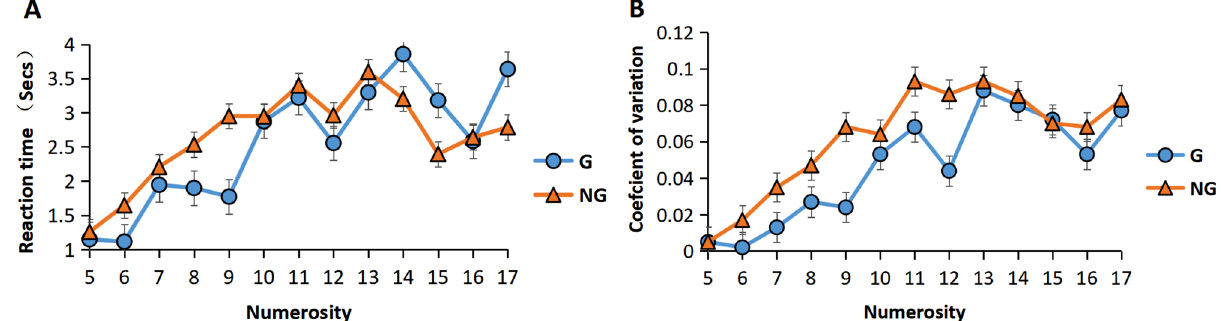
Figure 4. Specific numerosities. RTs ( A ) and CV ( B ) for different numerosities across group conditions.